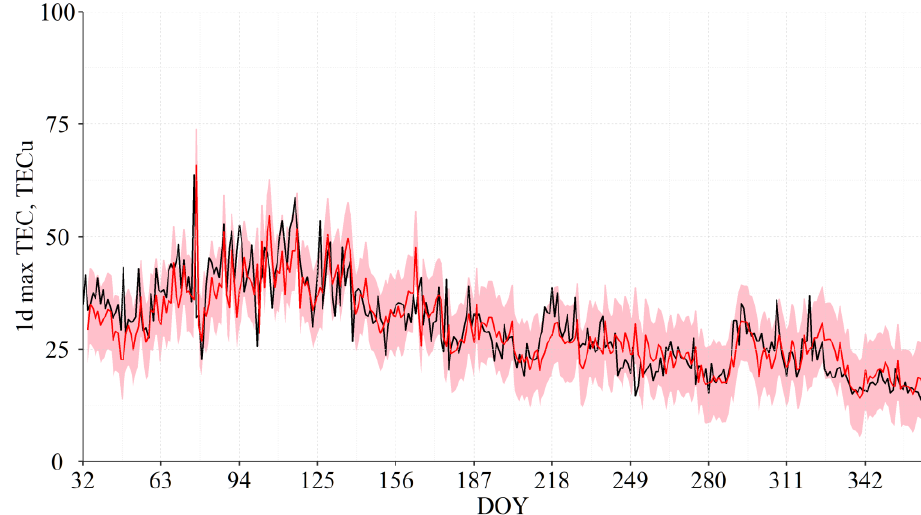
Figure 3. Observed (black) and forecasted using the PCA-MRM (L31, mean.lag1.2) model (red) 1 d max TEC series for February–December of 2015; pink area shows 90% confidence interval (see Section 5.3).